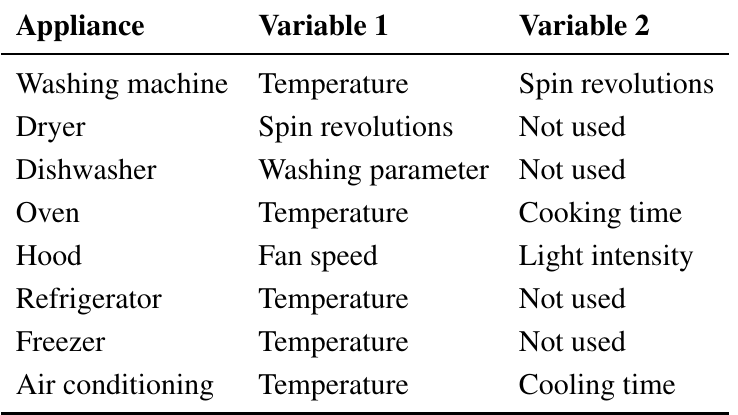
Table 1. Appliances variables supplied by the user to the control